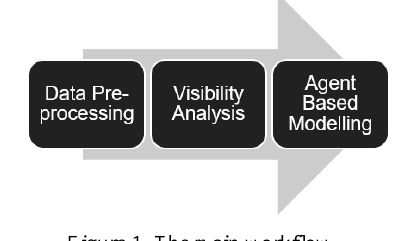
Figure 1. The main workflow